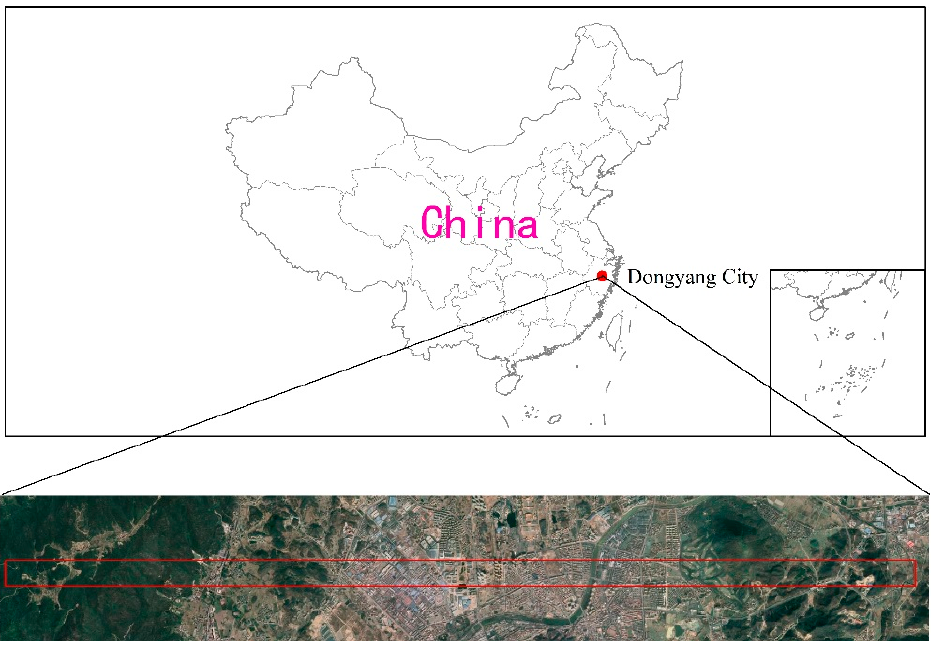
Figure 2. Location of the flight test.